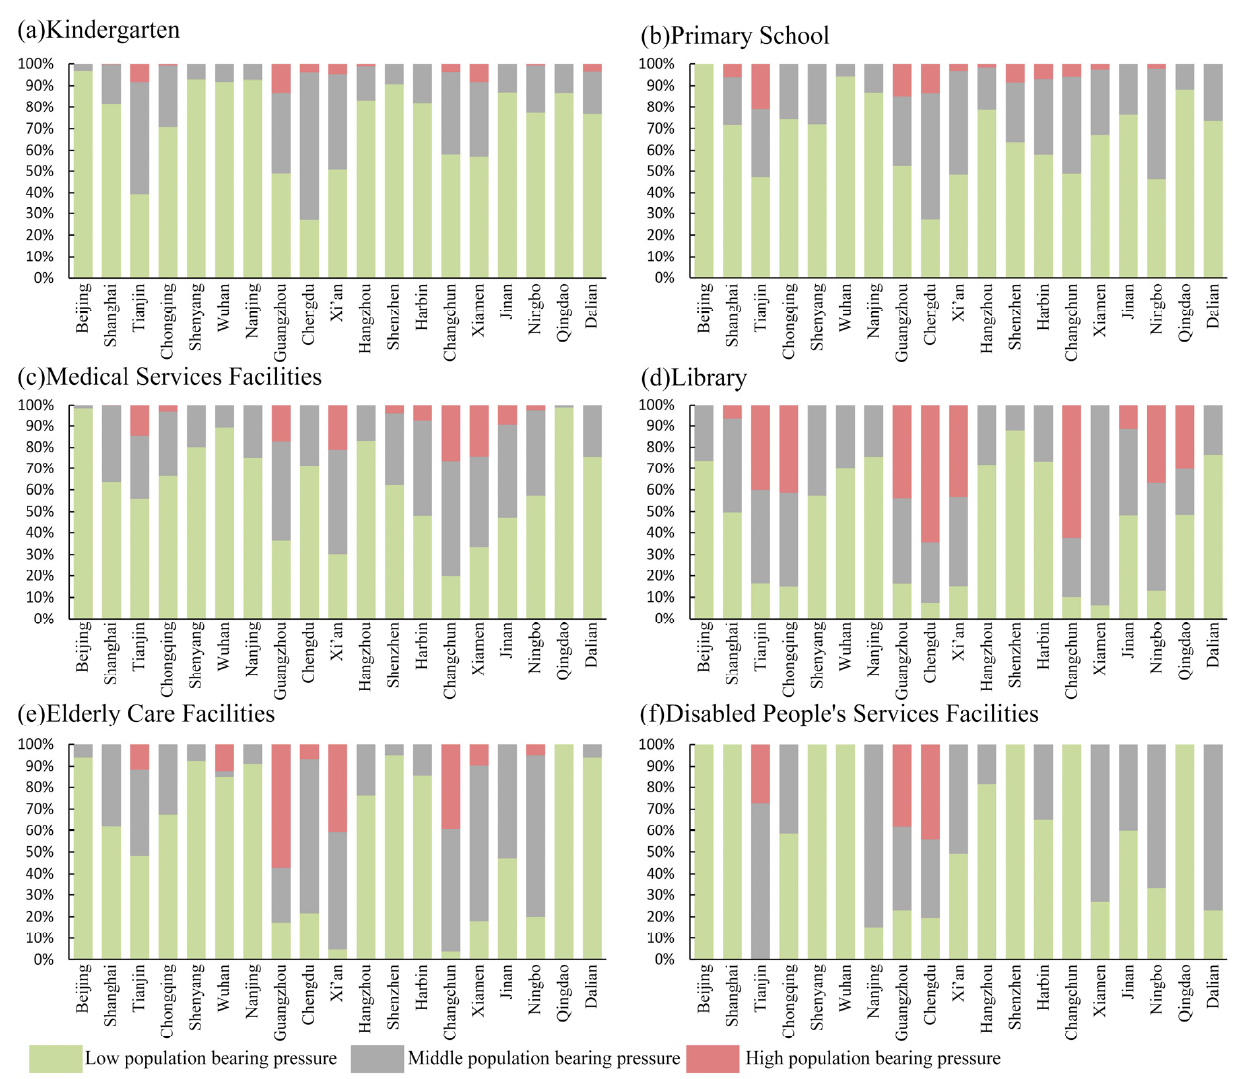
Figure 6. Statistical results of the population carrying pressure of facilities. ( a ) Statistical results of the population carrying pressure of Kindergarten. ( b ) Statistical results of the population carrying pressure of Primary School. ( c ) Statistical results of the population carrying pressure of Medical Services Facilities. ( d ) Statistical results of the population carrying pressure of Library. ( e ) Statistical results of the population carrying pressure of Elderly Care Facilities. ( f ) Statistical results of the population carrying pressure of Disabled People’s Services Facilities.